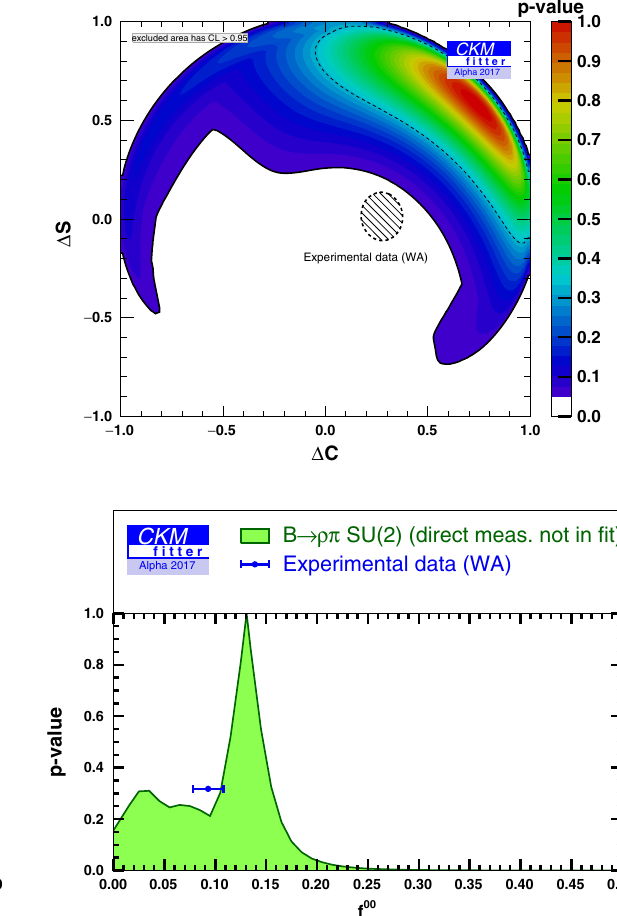
Fig. 34 Two-dimensional constraints on the B 0 → ρ ± π ∓ CP - violating parameters ( C ρπ , S ρπ ) and CP -conserving parameters ( (cid:13) C ρπ , (cid:13) S ρπ ) ( top ) and one-dimensional constraints on the flavour- integrated charge asymmetry A ρπ and the relative B 0 → ρ 0 π 0 branch-